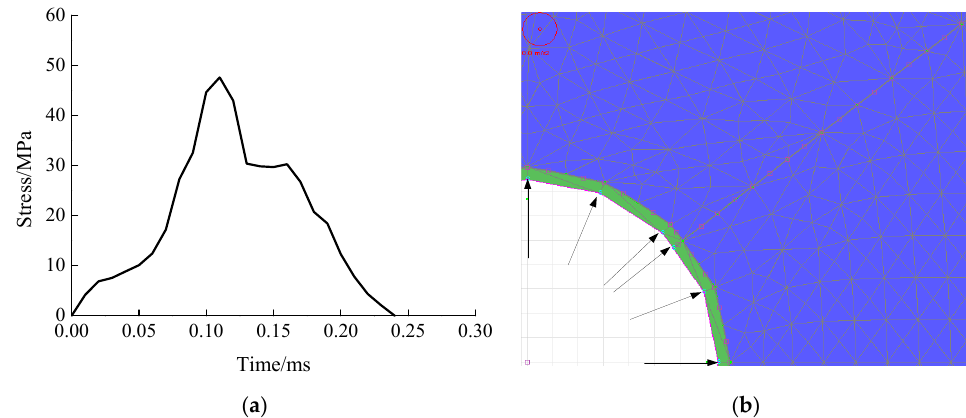
Figure 8. Measured blast load and applied schematic: ( a ) measured blasting load time curve; ( b ) blasting load application. P17 Measured curve P17 Numercial curve P18 Measured curve